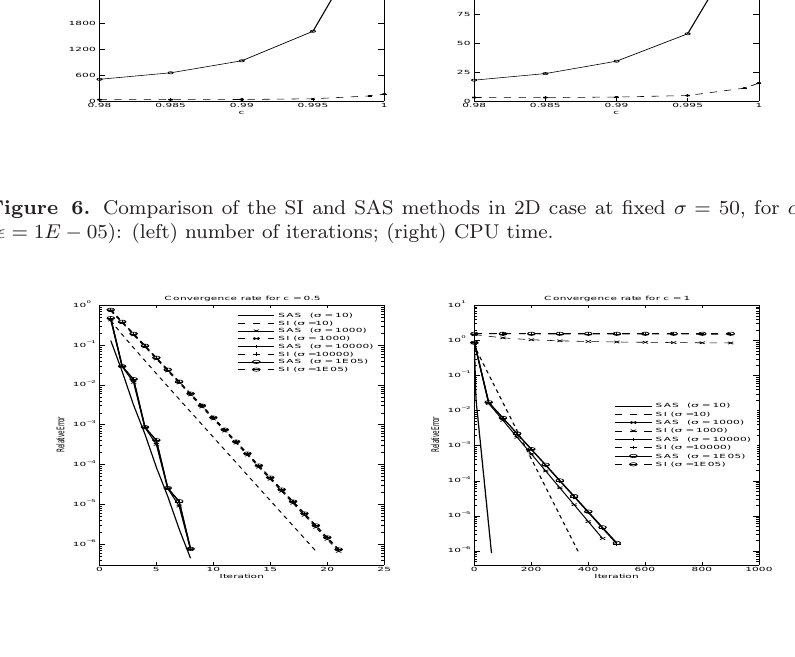
Figure 7. Comparison of the convergence rate in 2D case at fixed c of SI and SAS iteration for several values of σ : (left) c = 0 . 5 and (right) c = 1 .